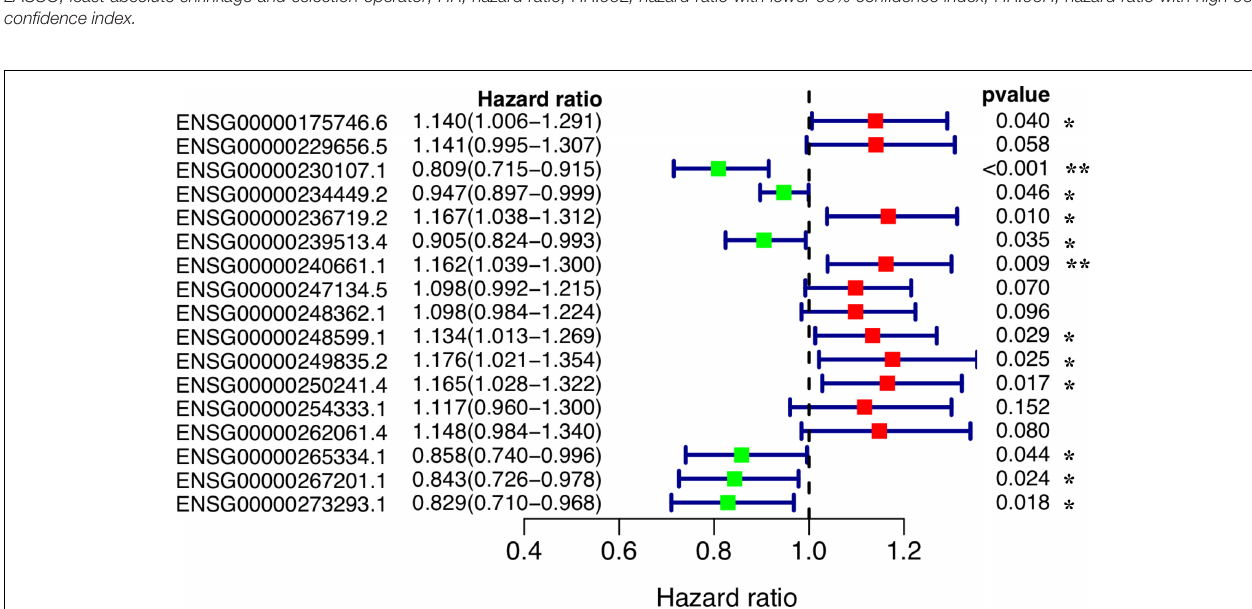
FIGURE 3 | Forest plot of the prognostic values of the prognostic model based on 17 ferroptosis-related lncRNAs. ** P < 0.01; * P <